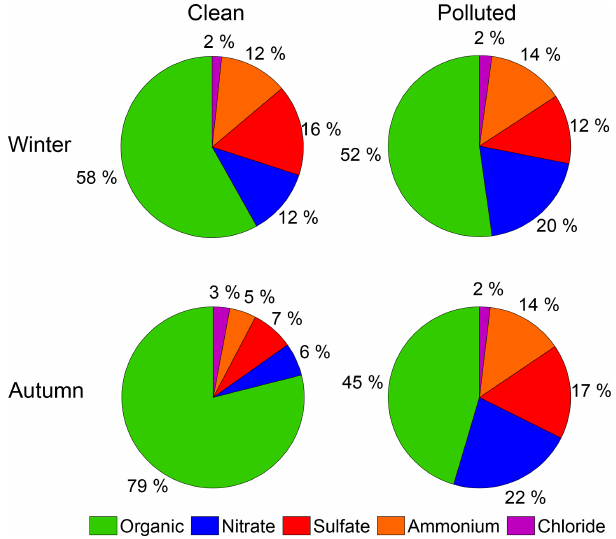
Figure 2. A comparison of the chemical composition during the clean and polluted periods from the autumn 2013 and winter 2015 field